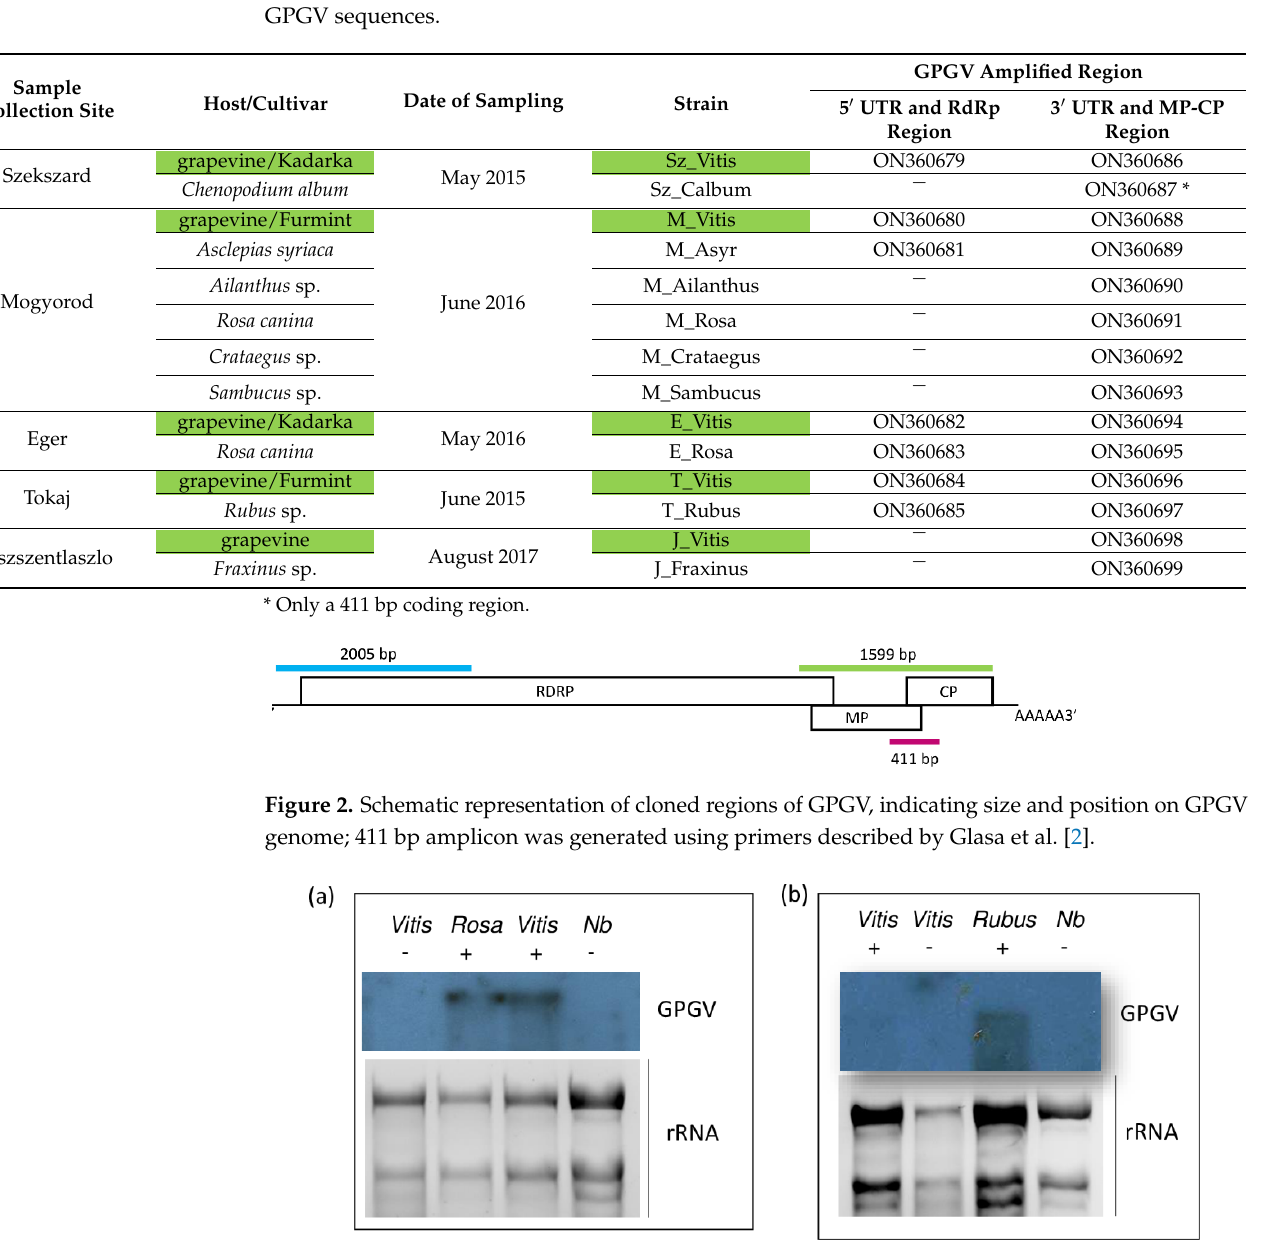
Figure 3. Northern blot detection of GPGV in samples collected at ( a ) Eger and ( b ) Tokaj. Vitis indicates RNA extracted from grapevine, Rosa from rose, and Rubus from Rubus, while Nb indicates RNA extracted from Nicotiana benthamiana used as a negative control. – and + indicate RT-PCR results for GPGV in same samples. Radiolabeled probe was used for hybridization. rRNA on EtBr-stained gel served as loading